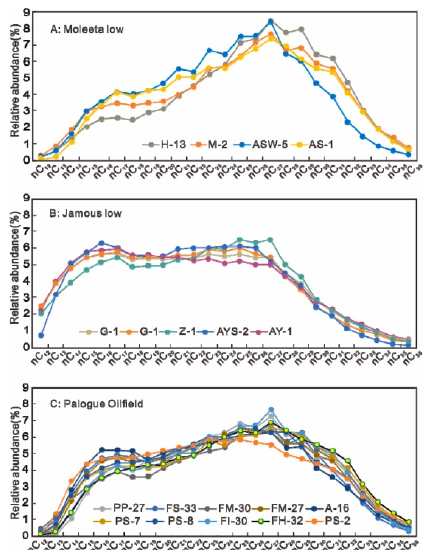
Figure 13. The distribution of n-alkanes of oil samples in the Palogue oilfield and the Moleeta and Jamous lows. (Adapted with permission from Ref. [50], 2022, Z. Shi.)